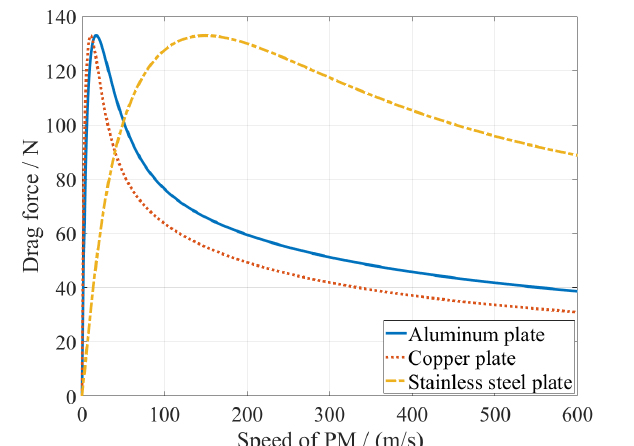
Figure 14. Variations in drag force due to the speed with different plate